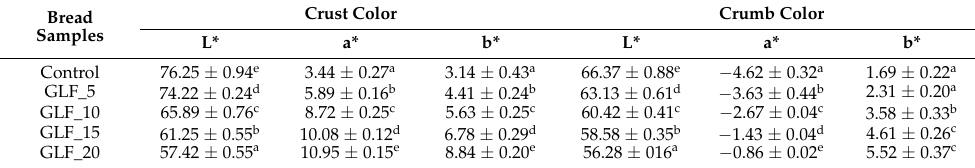
Table 5. Color parameters of the bread samples with different levels of GLF additions. Bread